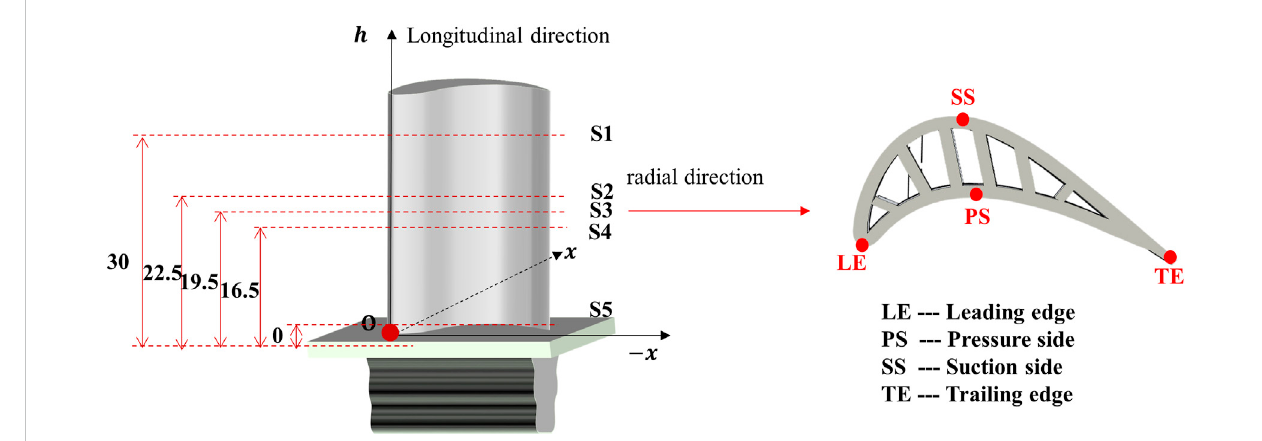
FIGURE 3 Selected locations of the observation points on each